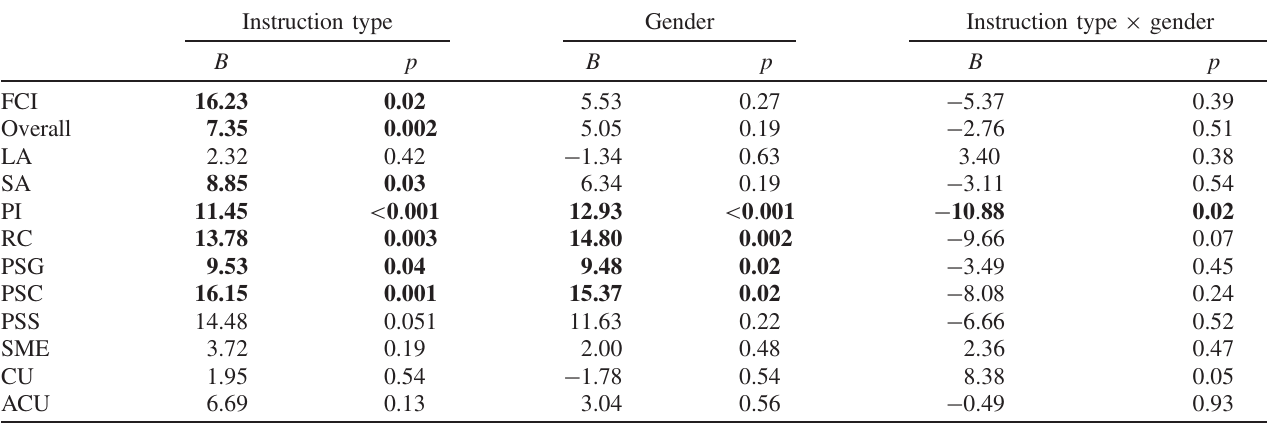
TABLE V. Unstandardized regression coefficients for the Fall-only CLASS and FCI. Bold cells indicate a significant effect ( p < 0 . 05